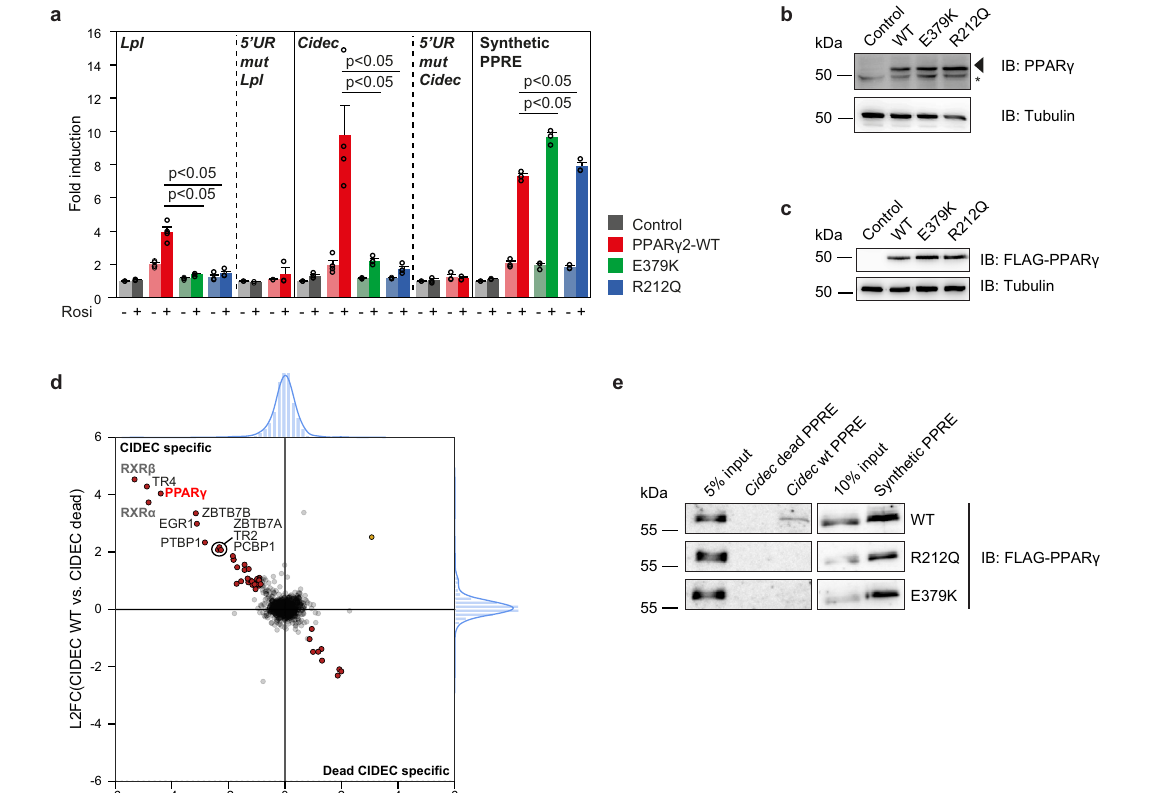
Threeindependentexperimentswereperformedandsimilarresultswereobtained. d DNA af fi nity puri fi cation-mass spectrometry analysis of Cidec PPRE interactors. Forward and reverse experiments were performed using oligonucleotides con- tainingthe Cidec PPREmotiforamutantversion( Cidec dead),followedbydimethyl labeling and mass spectrometry analysis. Log2 ratios (L2FC) of all identi fi ed and quanti fi ed proteins (from nuclear extracts) in both experiments were plotted against each other. Proteins binding equally well to both oligonucleotides center around log2(ratio)=0 and are marked in light gray. Proteins binding signi fi cantly better to the Cidec PPRE motif or the Cidec dead motif were determined by outlier statistics. These proteins are marked inred. e DNA af fi nity puri fi cationfollowedby western blot analysis were performed using oligonucleotides containing the Cidec PPRE motif, the Cidec dead motif and the synthetic PPRE motif. Pulldowns were performed using nuclear extracts containing the different FLAG-tagged PPAR γ proteins.Threeindependentexperimentswereperformed,andsimilarresultswere obtained. Source data for panel a – c and e are provided in the Source Data fi